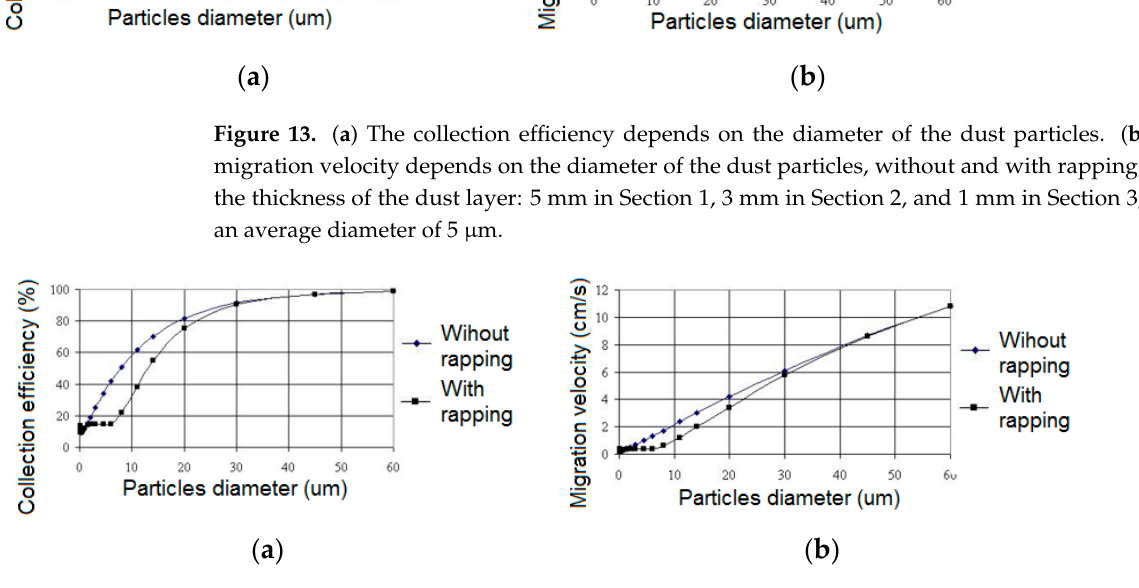
Figure 14. ( a ) The collection efficiency depends on the diameter of the dust particles. ( b ) The migration velocity depends on the diameter of the dust particles, without and with rapping, with the thickness of the dust layer: 5 mm in Section 1, 3 mm in Section 2, and 1 mm in Section 3, with an average diameter of 1 µ m. Collecting efficiency affects a broader class of dust particles with diameters less than 50 µ m, and the migration speed is slower (the larger the diameter of the dust particles, the slower the migration speed). Larger dust particles (60 µ m in diameter) are also affected. The larger the thickness of the dust layers, the poorer the collection efficiency. Collection efficiency falls as the average diameter of the dust particles